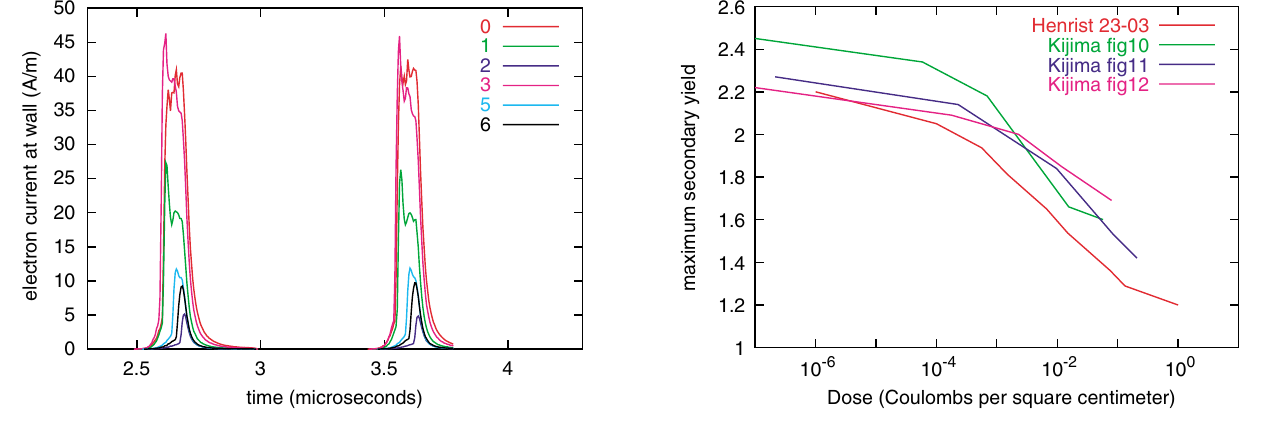
are * 15 pC = cm 2 = turn .